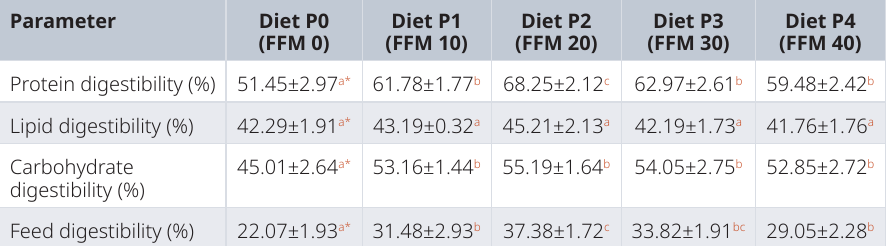
Table 2. Feed and nutrient (protein, lipid and carbohydrate)